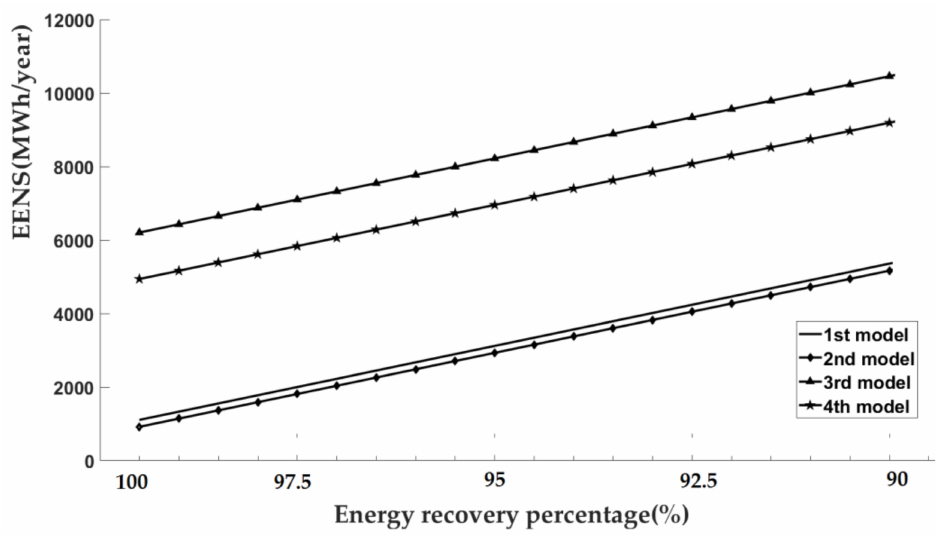
Figure 14. EENS of PLS for all